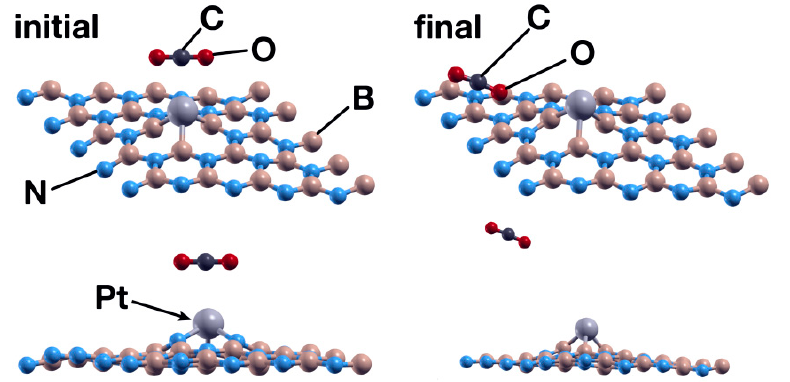
Figure 18. Initial ( left ) and final ( right ) configurations for the interaction of the hBN surface with a Pt absorbed in an N vacancy and a CO 2 molecule. As in the case where the Pt atom chemisorbs in a B vacancy, the surface repels the molecule. Table 1. Absorption energies (in eV) for the interaction between the hBN surface and a Ti atom or a Pt atom and the subsequent interaction with a CO 2 molecule.